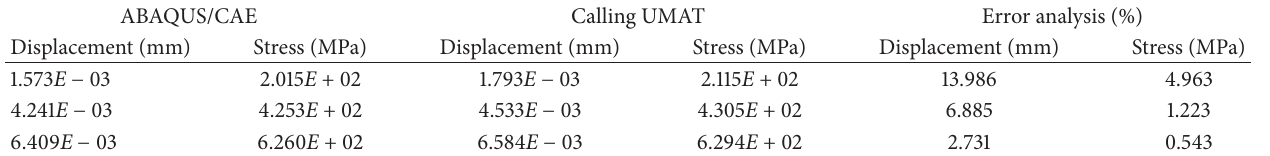
Table 7: The comparison of results between ABAQUS/CAE and